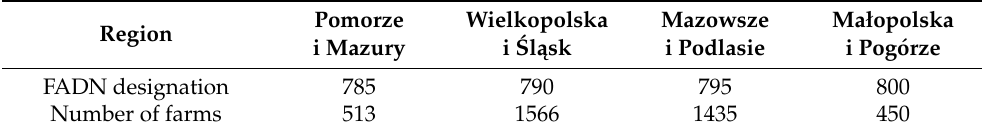
Figure 1. Polish Regions according to FADN. Source: own elaboration based on [78]. Out of all farms, only those characterised by continuous participation in the FADN database during the entire period under review (2004–2015) were approved for the study. The number of farms examined in individual regions is shown in Table 1. Table 1. The number of farms examined in individual